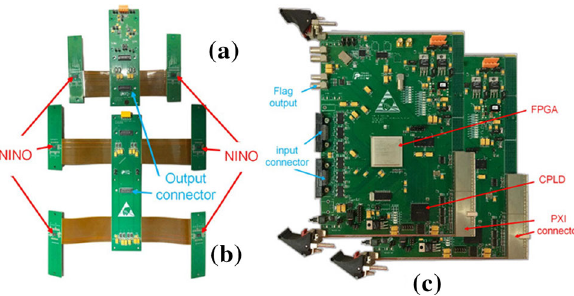
Fig. 6 NINO-basedFEEmodulesfortheinner( a )andouter( b )MRPC module. FPGA-based time-to-digital convertor is shown on the right ( c ). This FPGA TDC can achieve both leading and trailing edge time measurementwithhighprecision.Triggermatchingandotherfunctions are also